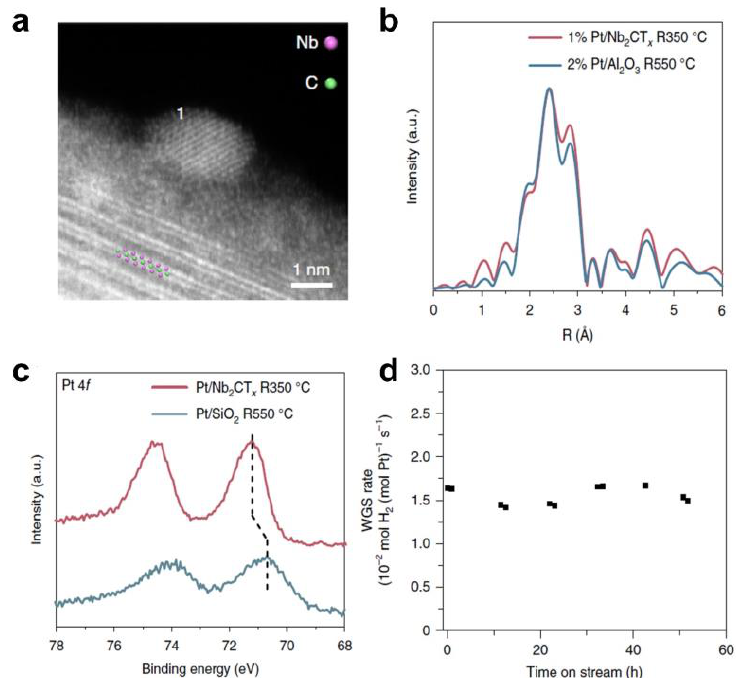
Figure 6. The reactive metal–support interaction of MXene–based catalysts. ( a ) HAADF–STEM images of typical nanoparticles supported by Nb 2 CT x MXene. The majority of each particle is hanging over the vacuum to avoid niobium interference from the support; ( b ) Fourier transform magnitude of the k 2 − EXAFS of the 2% Pt/Al 2 O 3 sample treated at 550 °C and fresh 1% Pt/Nb 2 CT x treated at 350 °C in 3% H 2 /He; ( c ) Quasi in situ XPS spectra of platinum 4f of Pt/SiO 2 reduced at 550 °C and 1% Pt/Nb 2 CT x reduced at 350 °C; ( d ) WGS rates normalized by the amount of platinum in the 1% Pt/Nb 2 CT x catalyst. The rates were measured at 300 °C. (Reprinted with permission from Ref. [80]. 2018 Springer Nature).